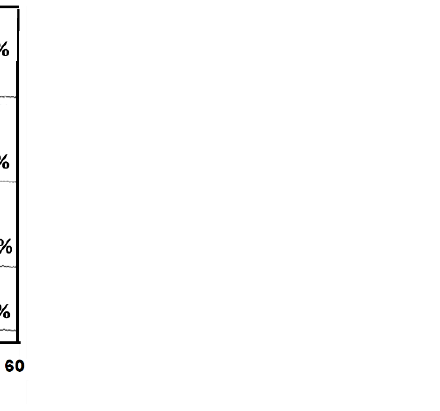
Figure 2. XRD patterns of the as-deposited ITO X thin films under different oxygen growth procedure parameters.